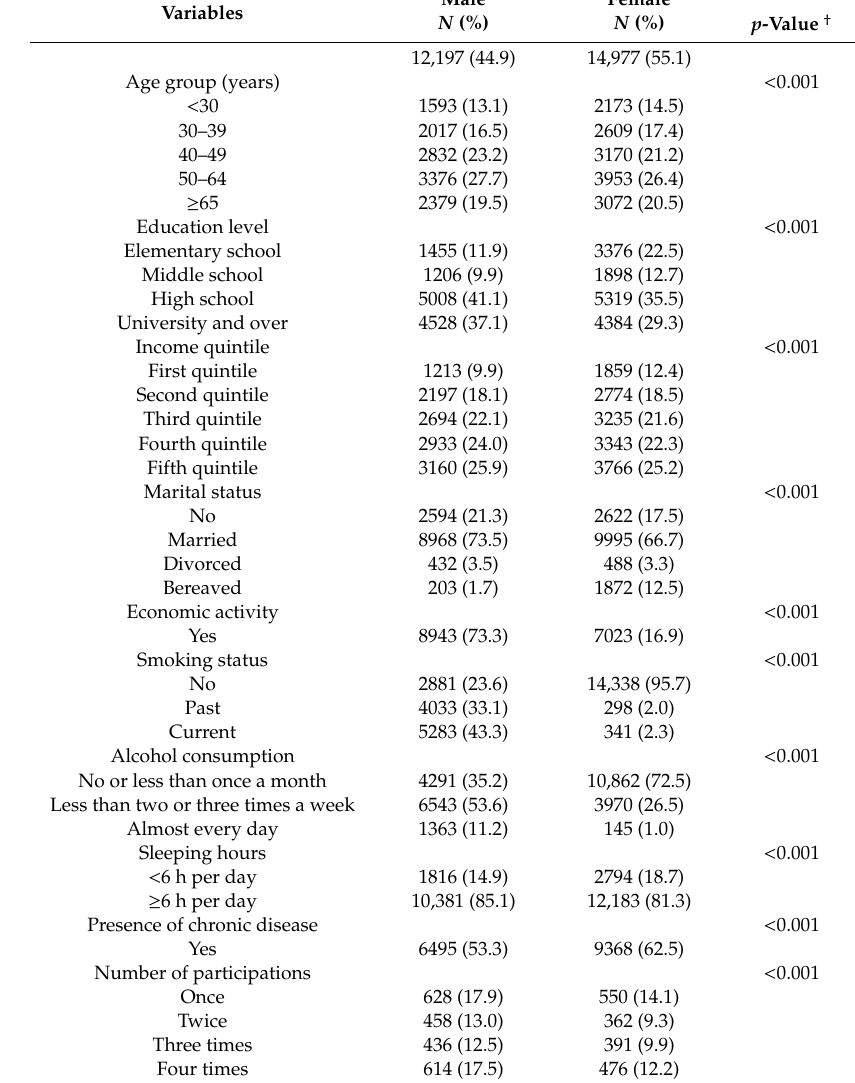
Table 1. Demographic characteristics of the study participants by sex in the Korea Health Panel data from 2009 to 2013 (total N = 27,174).